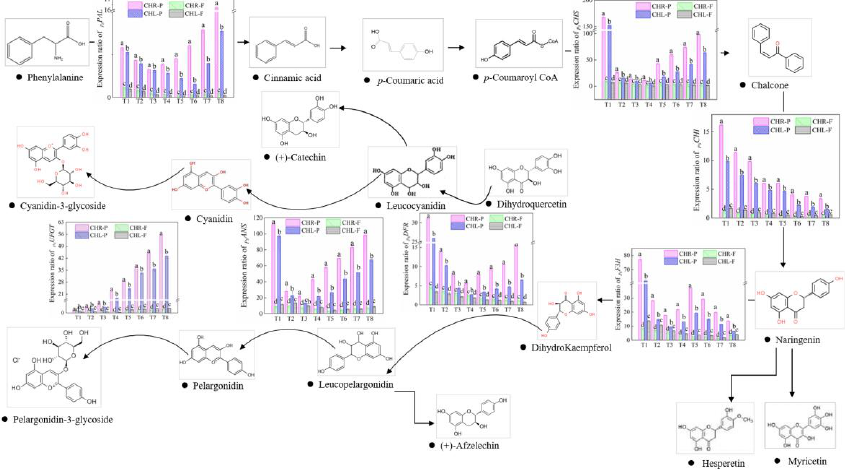
Figure 6. Part of the phenylpropanoid biosynthesis pathway, showing related pathways for flavo- noid and anthocyanin synthesis. The general pathway is catalyzed by phenylalanine ammonia-lyase ( Ps PAL ), chalcone synthase ( Ps CHS ), chalcone isomerise ( Ps CHI ), flavanone 3-hydroxylase ( Ps F3H ), di- hydroflavonol 4-reductase ( Ps DFR ), anthocyanidin synthase ( Ps ANS ), and UDPglucose:flavo- noid − 3 − O − glucosyltransferase ( Ps UFGT ). In addition, the gene expression data are present in the corresponding part. Each value is the mean for three replicates. The vertical bar indicates the stand- ard error. Columns with different letters differ significantly at p < 0.05.